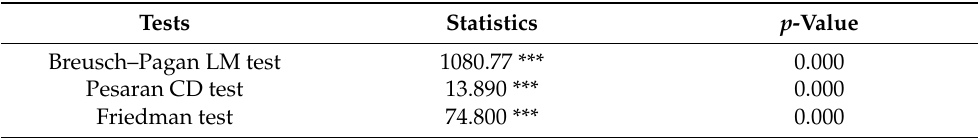
Table 3. Cross-sectional dependence test results.